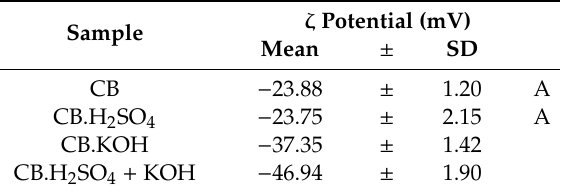
Table 4. ζ potential results of carbon black